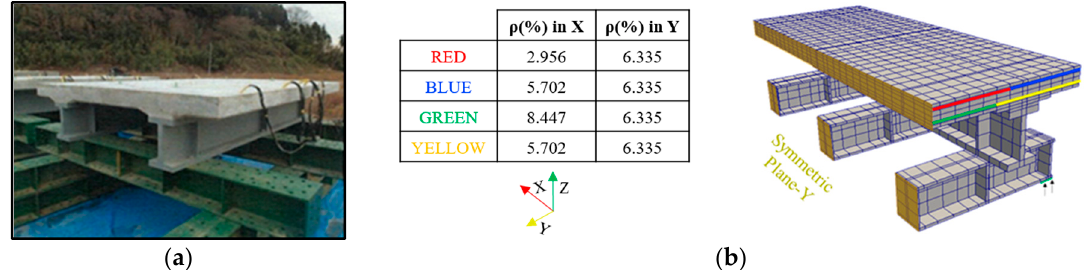
Figure 14. ( a ) Overview of mock-up slab specimen; ( b ) FE model of half of the mock-up specimen.